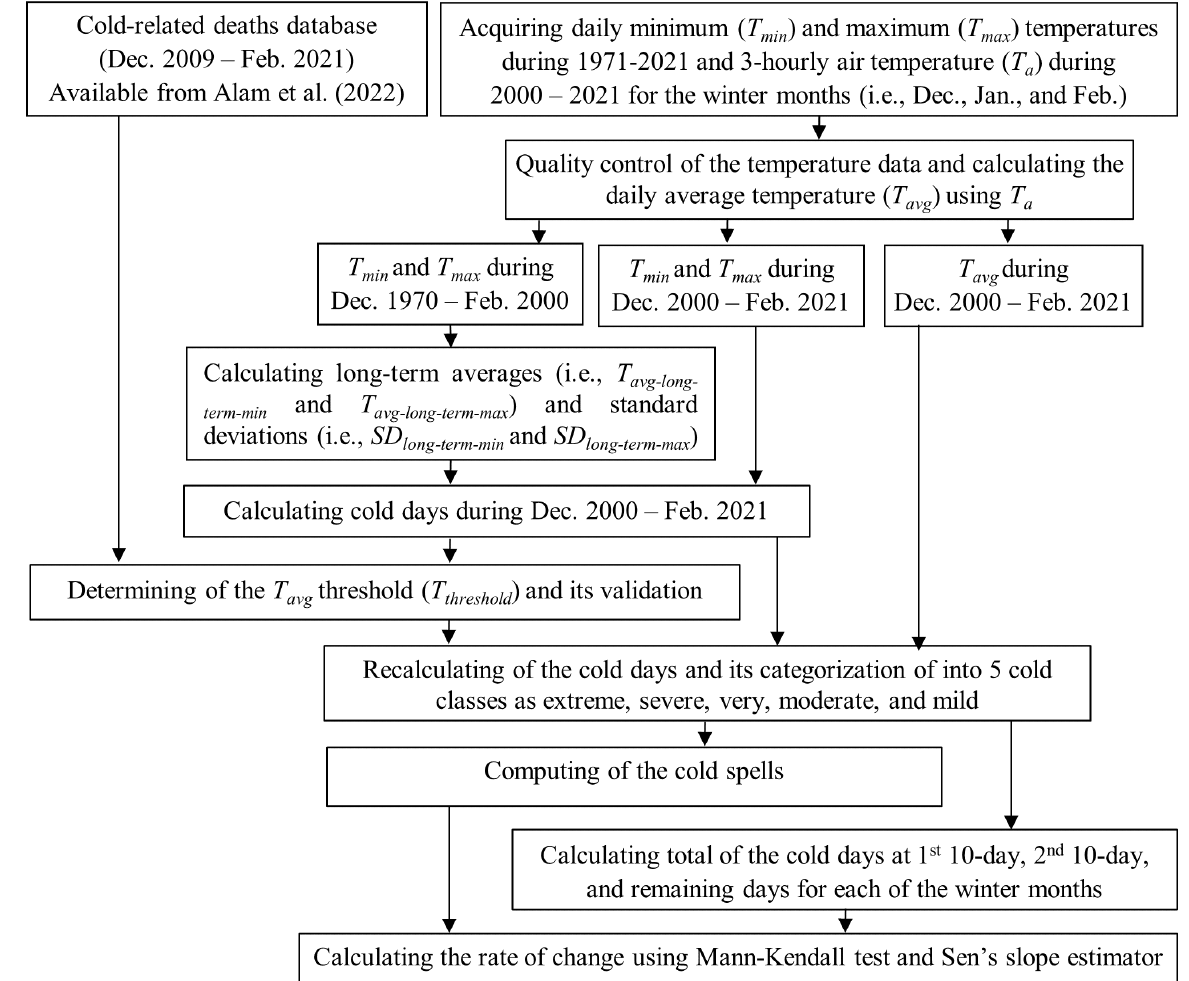
Figure 2. A schematic diagram illustrates the concept of developing methods for characterizing cold days and